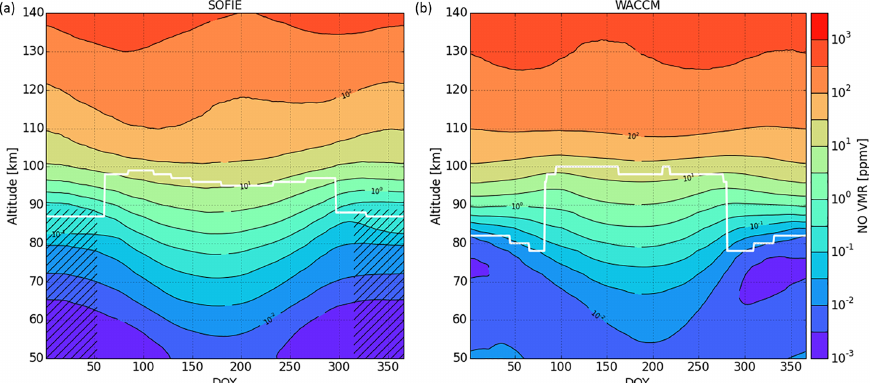
Figure 2. Seasonal climatology of Antarctic NO volume mixing ratio, similar to Fig. 1. The white contour line represents the climatological mesopause altitude. Hashed areas represent the Antarctic PMC season, during which SOFIE data should not be compared to the WACCM climatology (see more information in Sect.